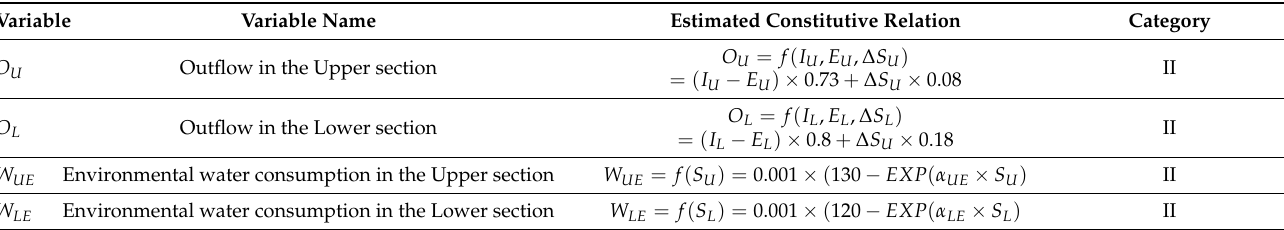
Table A3. The constitutive equations of Class